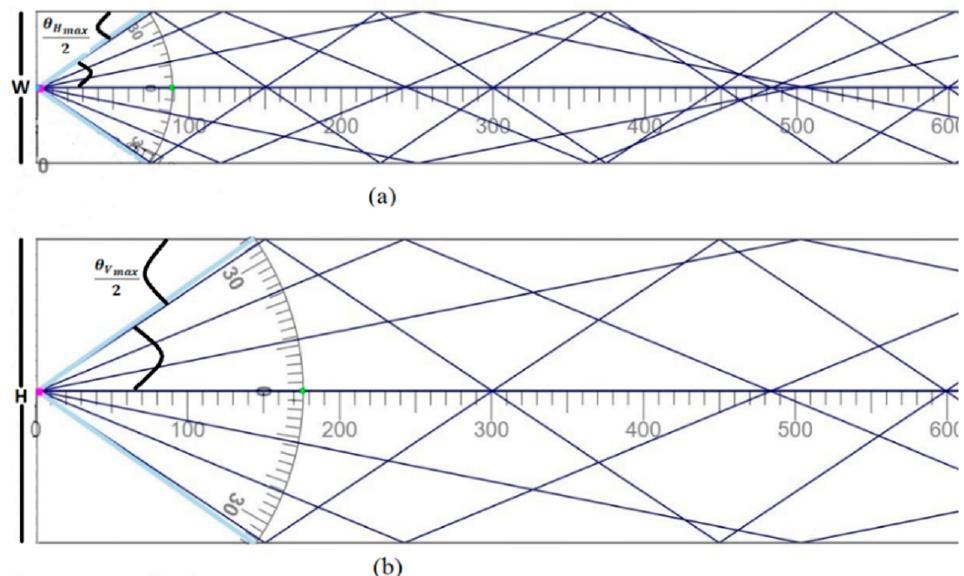
Figure 1. A two-dimensional illustration of ray tracing inside a tunnel from the ( a ) side walls, and ( b ) ceiling/floor reflections.